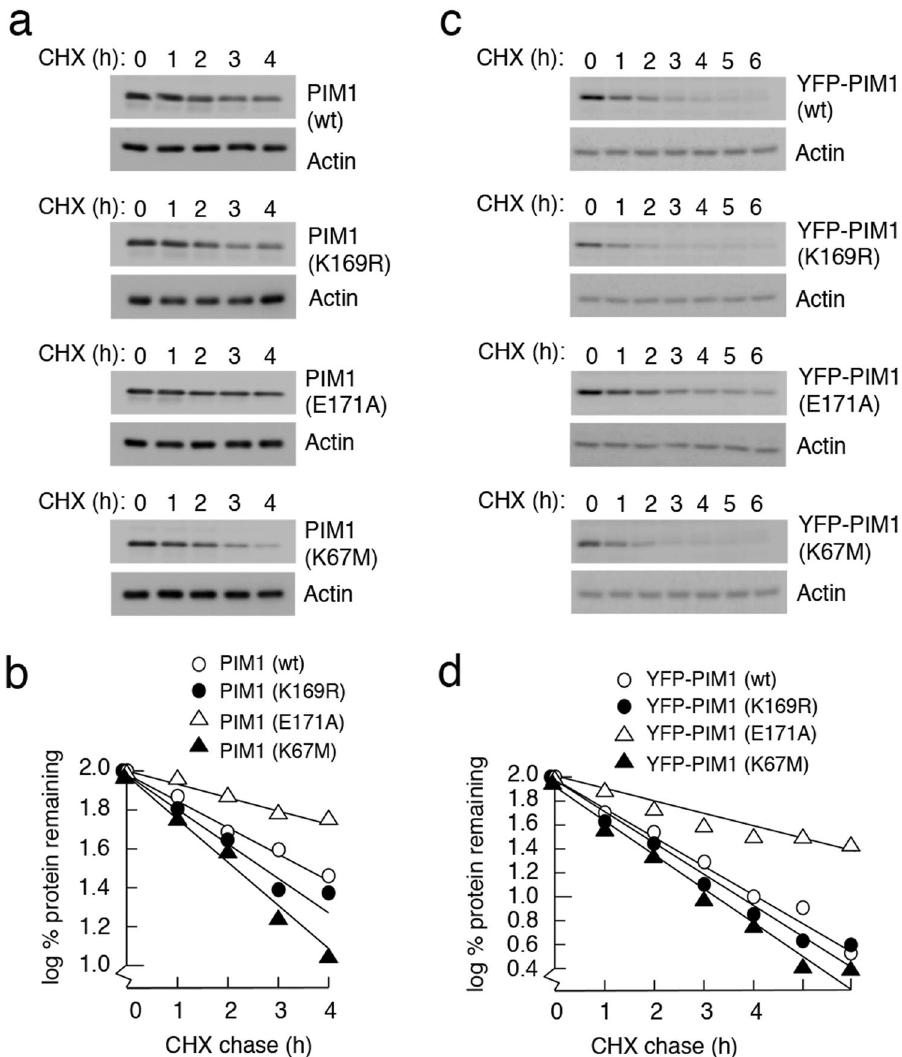
Figure 6. SUMOylation regulates PIM1 stability. ( a ) Plasmids encoding WT MYC-PIM1, PIM1 SUMO mutants (MYC-K169R and MYC-E171A) and a catalytically inactive mutant (MYC-K67M) were transiently transfected into H1299 cells. Cycloheximide was added to the cells 24 hours post transfection at a final concentration of 50 μ g/ml to inhibit protein synthesis, and harvested at the indicated time points. The cell lysates were analyzed by western blotting using PIM1 (12H8) antibody. Actin was used as a loading control. ( b ) PIM1 band intensity in each case was quantified relative to the zero time point, using Biorad ImageLab software, and plotted on a graph as percentage of protein remaining in log scale. ( c ) HeLa-FRT cells expressing YFP-tagged WT PIM1 or mutant PIM1 were treated with 50 ng/ml doxycycline for 24 hours to induce protein expression, following which cycloheximide chase assay was performed as done in panel A. ( d ) PIM1 protein levels were quantified and represented graphically as done in panel